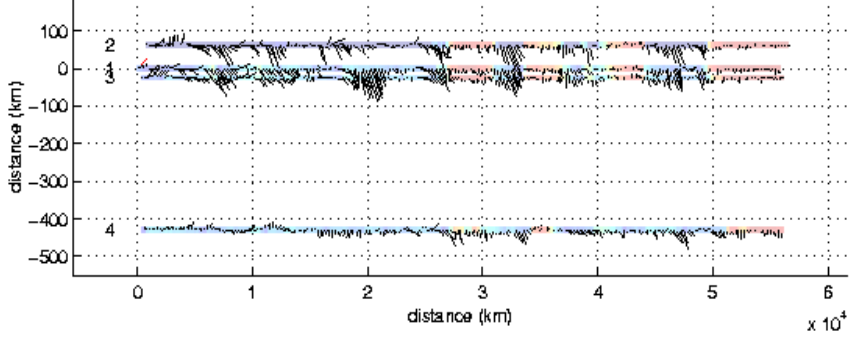
Figure 15. Fig. 15. A combined plot: X -axis is in the direction antiparallel to the phase velocity, v = ( − 144 , 79 , 89 ) km/s GSE, of the surface wave along the magnetopause, Y -axis is perpendicular to X and the magnetic field (thus in the plane of the magnetopause). The satellite trajectory is projected onto this plane and colored according to − V sc values. In addition, the black lines show the direction of the electric